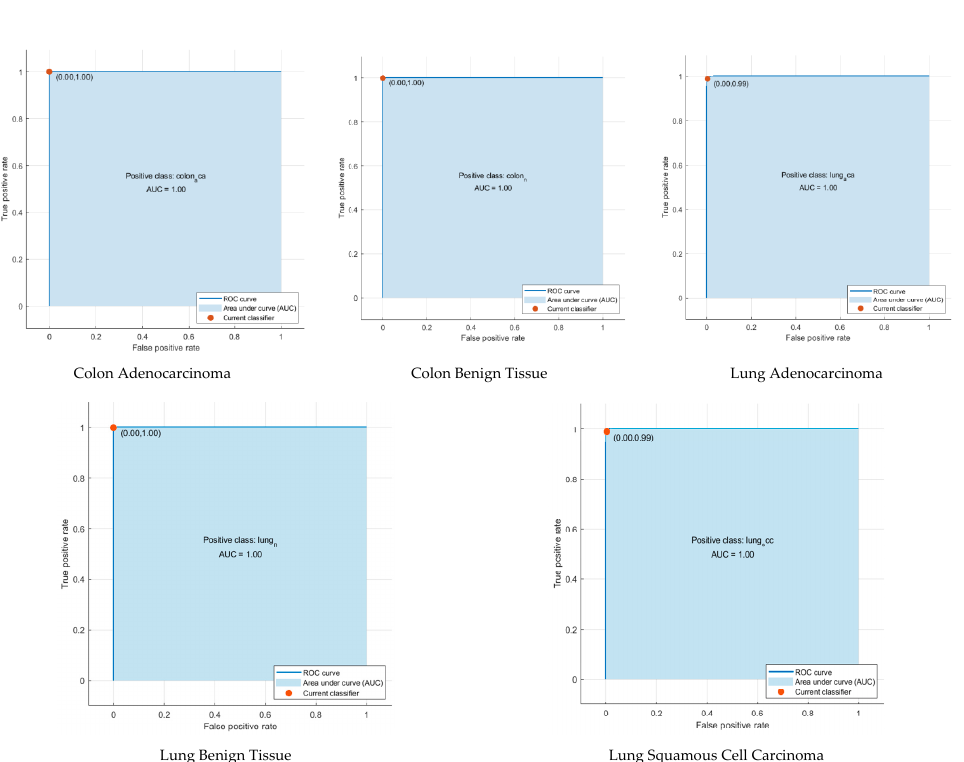
Figure 6. ROC curves of each class as a result of the CNN-PCA-SVM structure. Table 2. Performance measures attained using the combined PCA coefficients of the three CNNs.